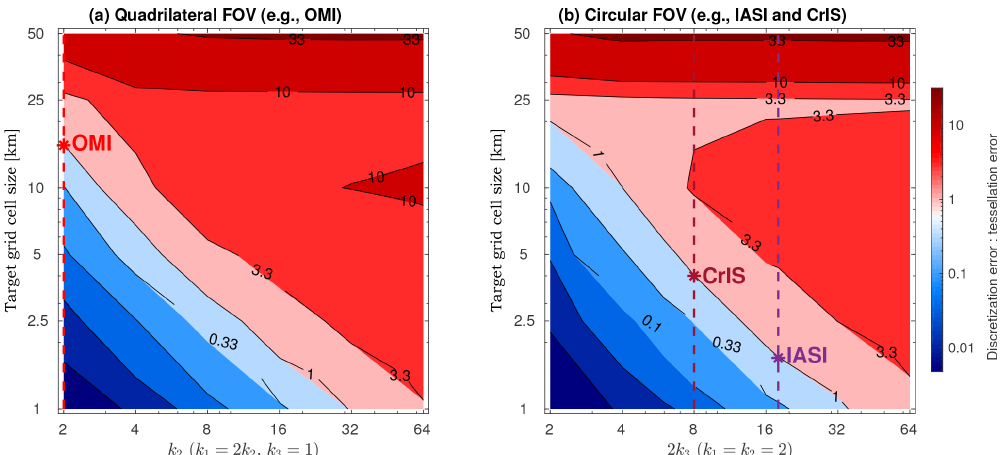
Figure 7. (a) The ratio between discretization and tessellation errors for different combinations of spatial response function shapes and target grid size. The unity contour line delineates the regime where the tessellation error is larger than the discretization error (blueish contours) and the regime where the discretization error is larger than tessellation error (reddish contours). The red vertical dashed line indicates the approximate spatial response for OMI. The red star marks the threshold target grid size where the tessellation and discretization errors are equal for OMI. (b) Similar to panel (a) but the IASI pixel shapes and locations are used instead of OMI. The spatial response function exponents for CrIS and IASI and their intersects with the unity contour line are